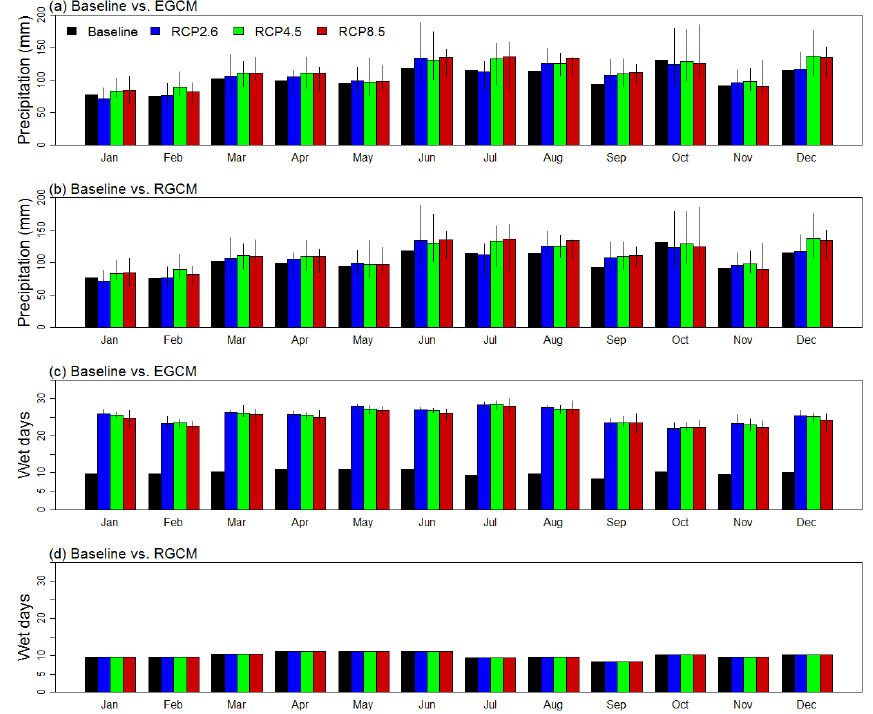
Figure 4. Comparison of the monthly average ( a , b ) precipitation and ( c , d ) wet days of EGCM (GCM with the excessive number of wet days) and RGCM(GCM with the reasonable number of wet days).